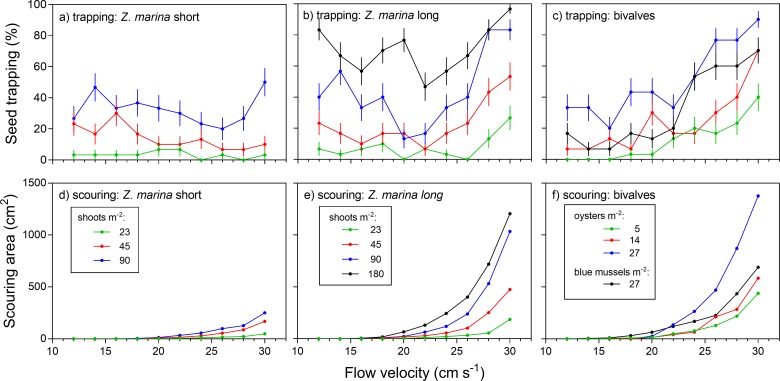
Trapping of eelgrass seeds (Mean ± SE, n = 30) and size of corresponding scouring patterns in different biogenic structures in relation to flow velocity; a), d) short shoots (< 15 cm); b), e) long shoots (> 25cm) and c), f) bivalves.